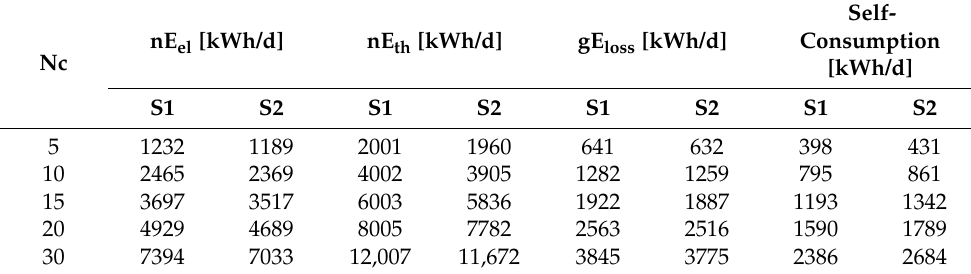
Table 10. Results of Nh, N CHP , and PBT values for Scenario 1 (S1) and Scenario 2 (S2).